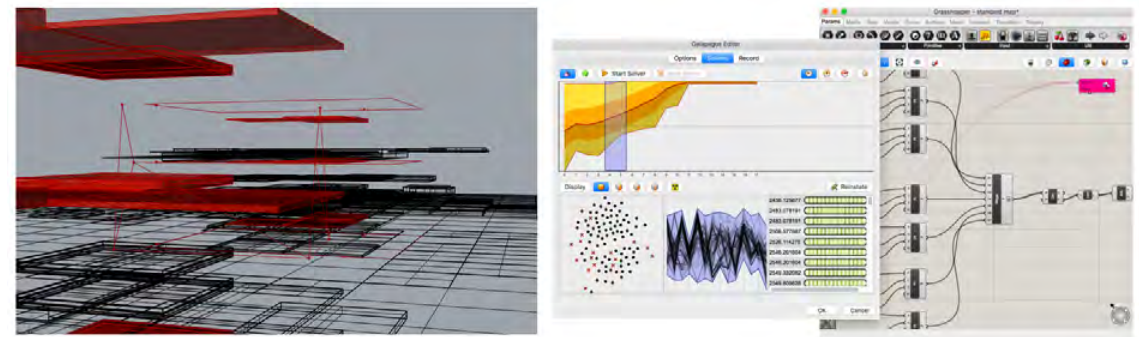
Figure 13. Solversprovided by Galapagos (above